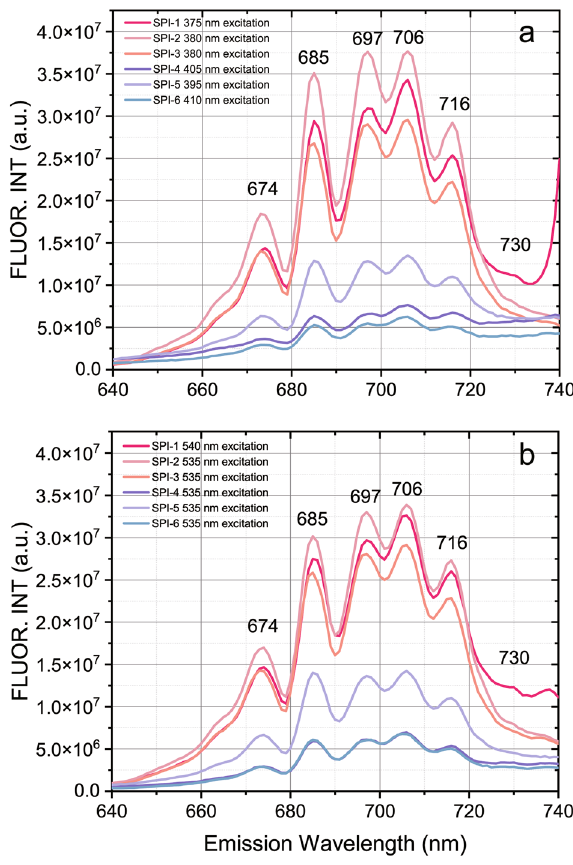
Figure 3. Emission spectra of the present spinels in specific excitation wavelength. ( a ) emission spectral curves excited by ~ 380 nm radiation. ( b ) Emission spectral curves excited by ~ 535 nm